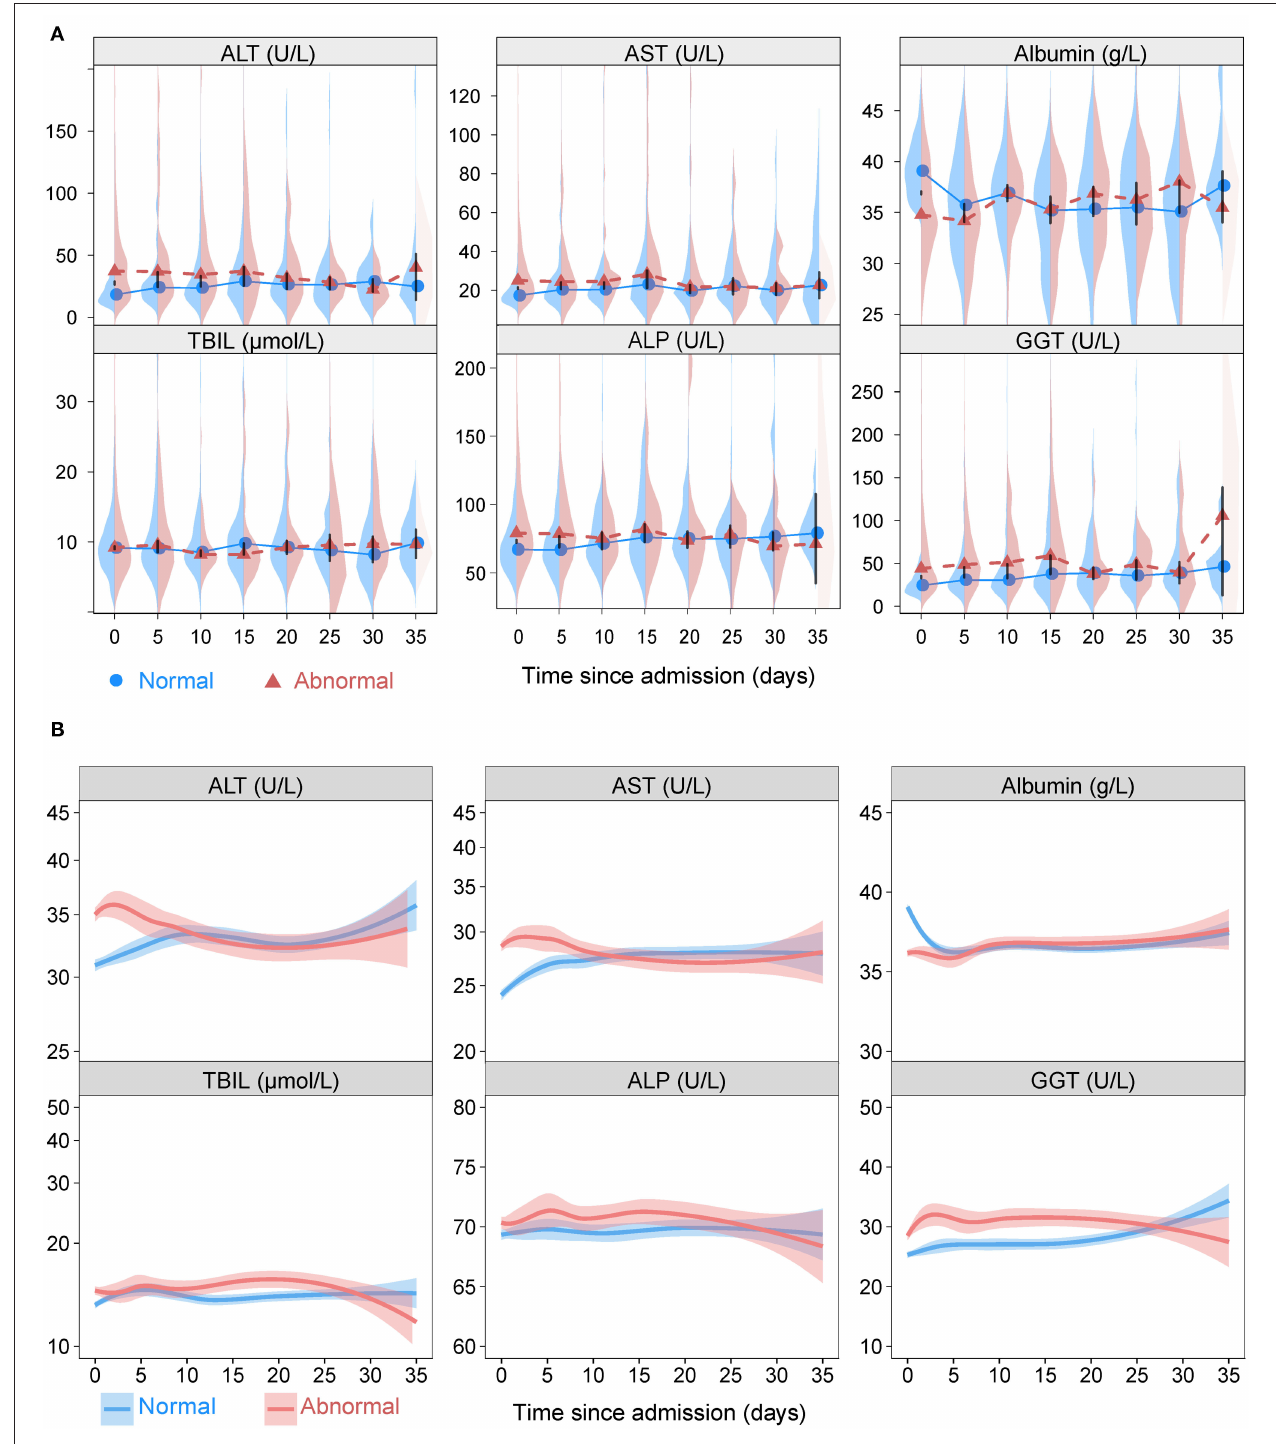
FIGURE 2 | The liver function variations. (A) Longitudinal back-to-back violin plots showing the variations of ALT, AST, albumin, TBIL, ALP, and GGT during follow-up stratified by presence or absence of abnormal liver function tests on admission. Circles and triangles indicate medians. The black vertical bars have lengths equal to one-half the length of the 95% confidence interval for the difference in medians. When this bar does not touch the circles and triangles, there is a significant difference in medians at the 0.05 level. (B) Smooth trajectories of mean ALT, AST, albumin, TBIL, ALP, and GGT by disease severity with 95% confidence band based on locally weighted scatterplot smoothing stratified by presence or absence of abnormal liver function tests on admission. ALT, alanine aminotransferase; AST, aspartate transaminase; ALP, alkaline phosphatase; GGT, gamma-glutamyltransferase; TBIL, total bilirubin abnormal.